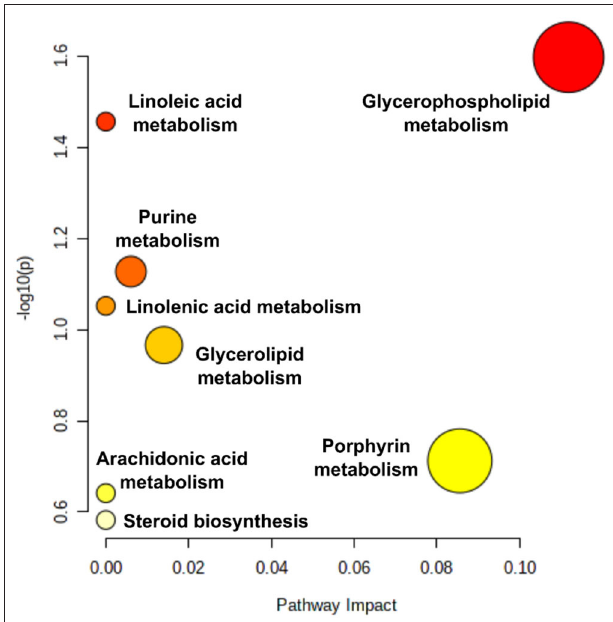
FIGURE 3 | Pathway impact: pathway analysis based on enrichment analysis procedures, identifying the most relevant metabolic pathways via pathway impact and adjusted p . The figures were generated using MetaboAnalyst 4.0 (www.metaboanalyst.ca). Pathway impact here represents a combination of the centrality and pathway enrichment results; higher impact values represent the relative importance of the pathway; the size of the circle indicates the impact of the pathway while the color represents the significance (the more intense the red color, the lower the p